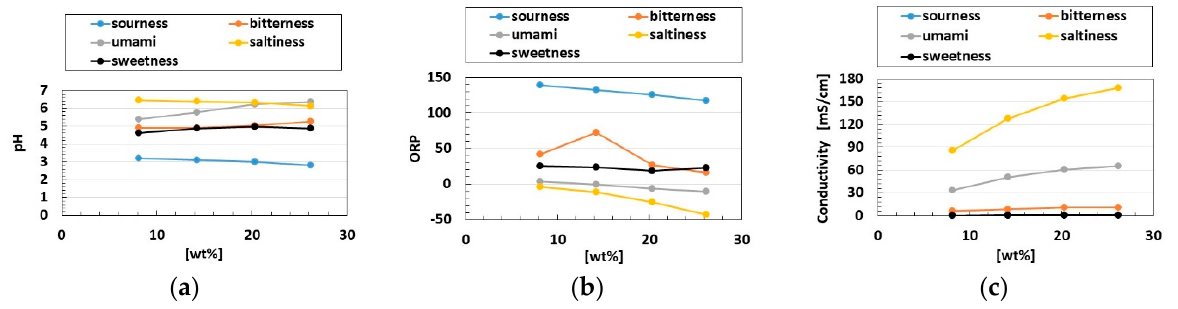
Figure 8. Properties of the substances used for the five tastes: ( a ) pH; ( b ) ORP; ( c ) conductivity, the line of sweetness taste lies on top of the one of sourness one another because of sourness’s diminutive quantitative values.